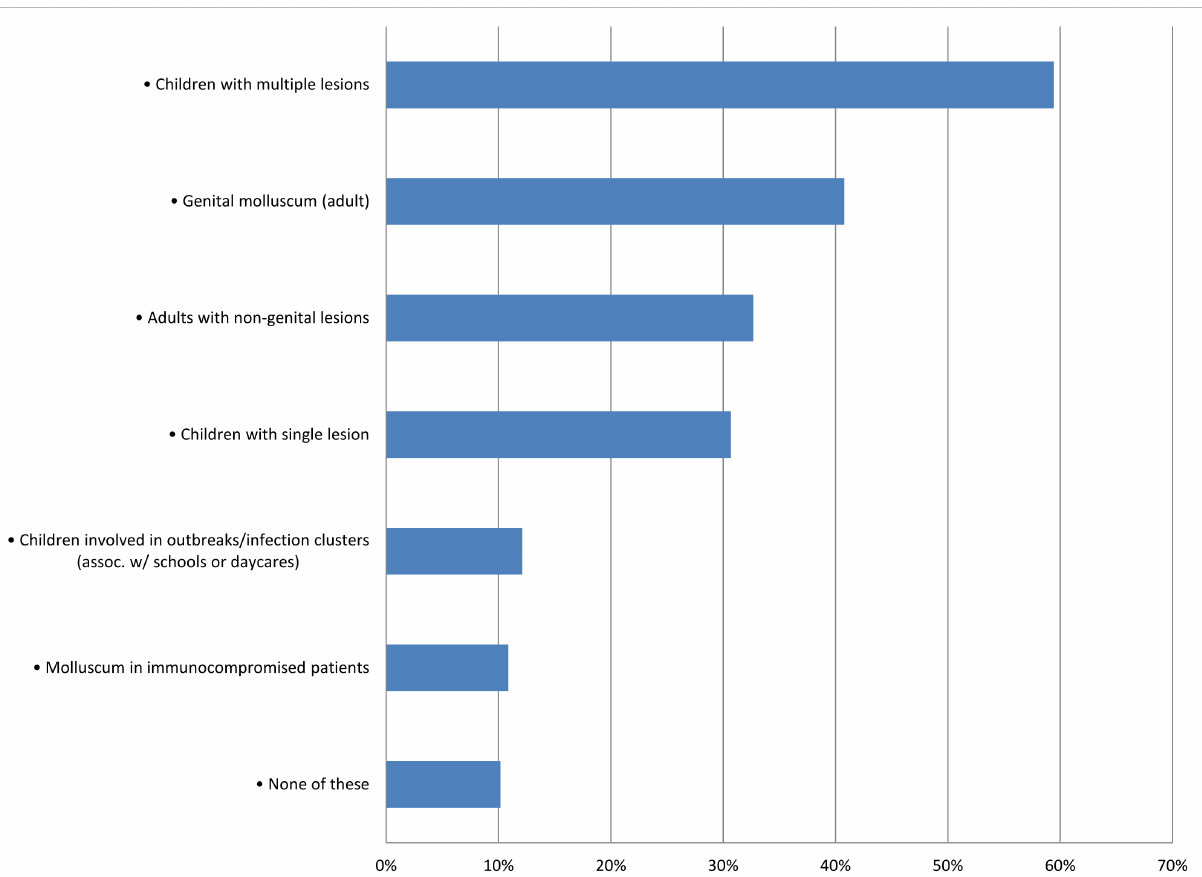
Figure 2. Percent respondents who reported seeing these types of molluscum contagiosum cases in the last one year.